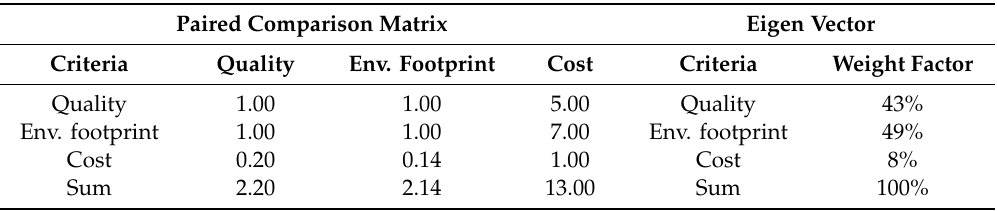
Table 10. Paired comparison matrix level 1 by equally prioritizing Quality and Env.Footprint (left) and the derived normalized Eigen vector (AHP priority vector) (right). Paired Comparison Matrix Eigen Vector